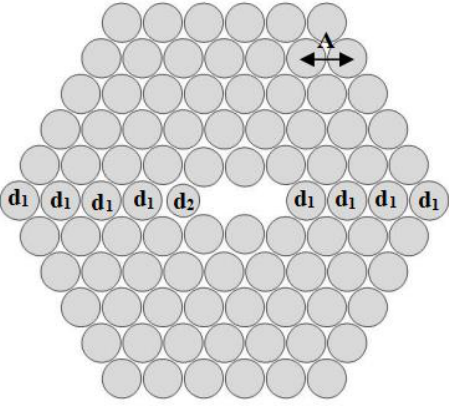
Figure 1. Cross-section of proposed photonic crystal fiber (PCF) design methodology.